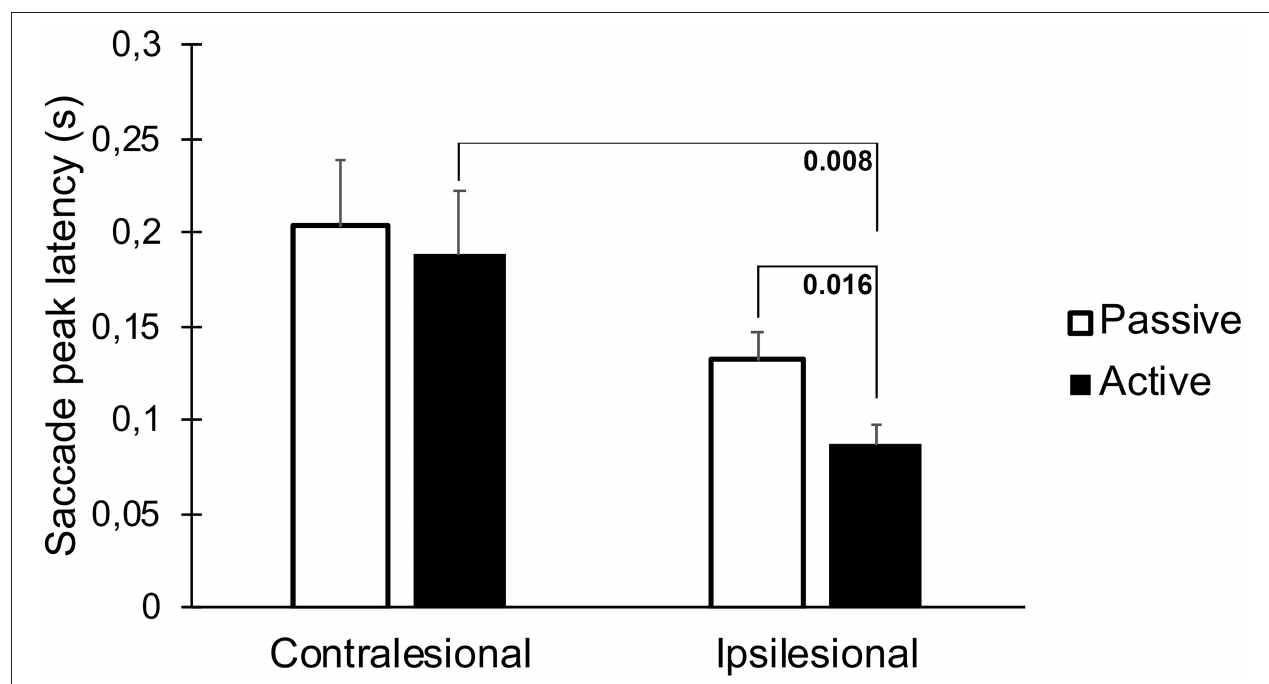
FIGURE 4 | Latency to the first saccade when performing head thrusts in the ipsilesional and contralesional directions with active and passive head movements. Bars representing mean values for the group. Error bars indicate SEM. Bonferroni corrected post- hoc statistics presented numerically.